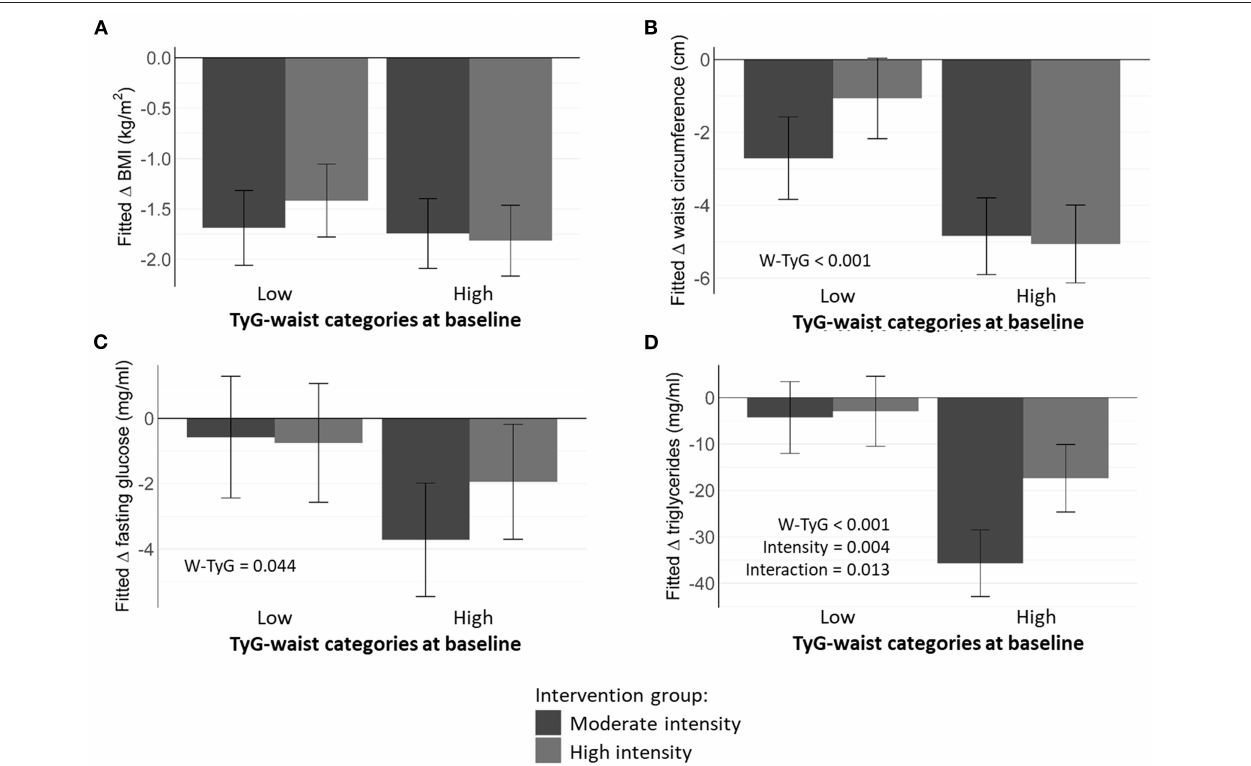
FIGURE 3 | Estimated marginal means of metabolic markers depending on baseline TyG- waist categories and physical activity (high vs. moderate). (A) Fitted change in BMI; (B) Fitted change in waist circumference; (C) Fitted change in fasting glucose; (D) Fitted change in